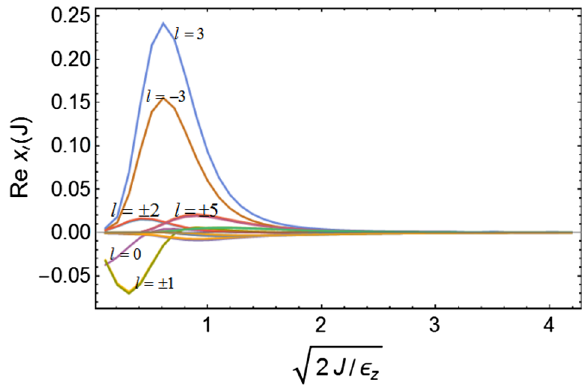
ð J Þ of the most unstable l ¼ 0 . 546 , N ¼ N 0 . x